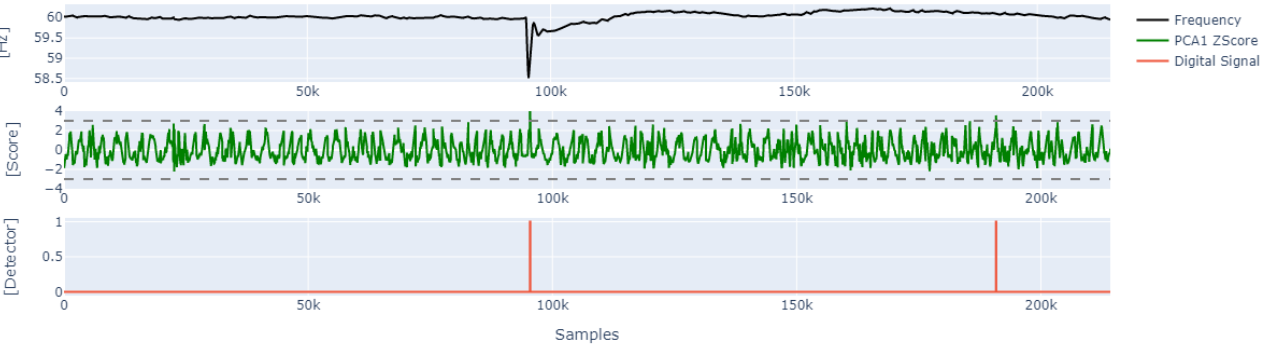
Figure 8. Event 1: detector event of PMU Apucarana (located at Parana State).